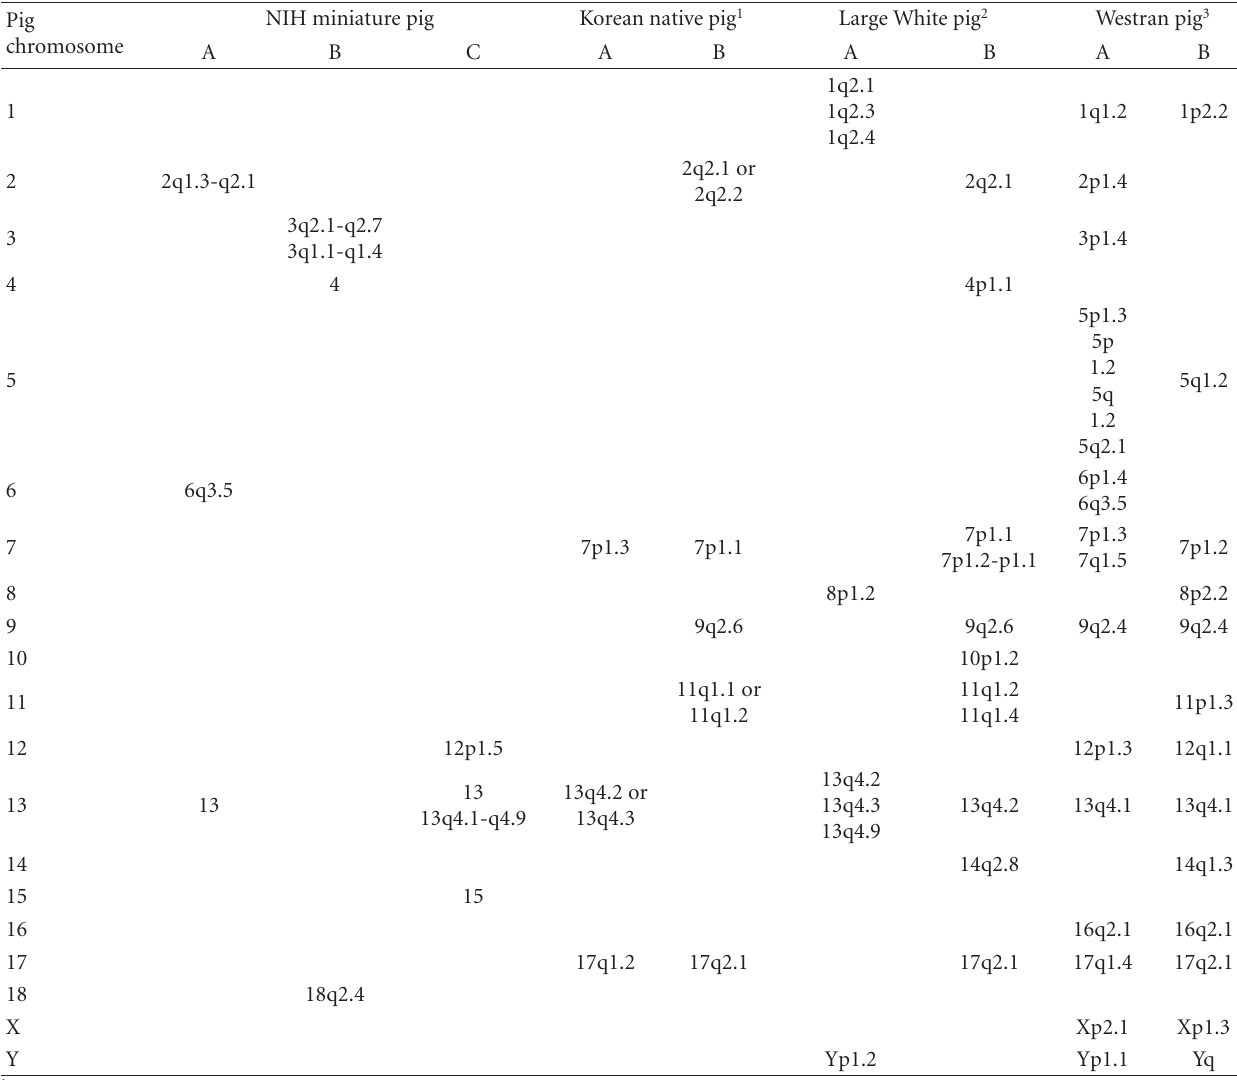
Table 3: Comparison of characterized PERV-A, PERV-B and PERV-C integration sites in di ff erent four breeds.